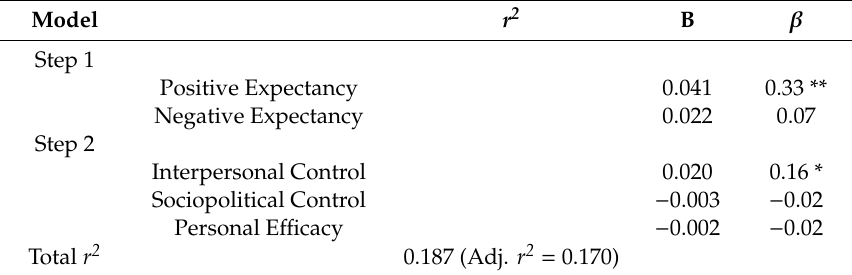
Table 6. Alcohol consumption regressed on expectancies and self-e ffi cacy. Model r 2 B β Step 1 Positive Expectancy 0.041 0.33 ** Negative Expectancy 0.022 0.07 Step 2 Interpersonal Control 0.020 0.16 * Sociopolitical Control − 0.003 −